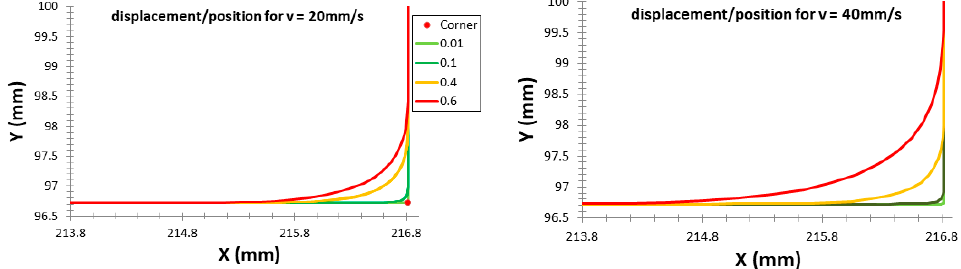
Figure 6. Position register (X and Y axes) in the vicinity of the corner for different values of e: X.XX and two speeds (v = 20 mm/s and v = 40 mm/s).